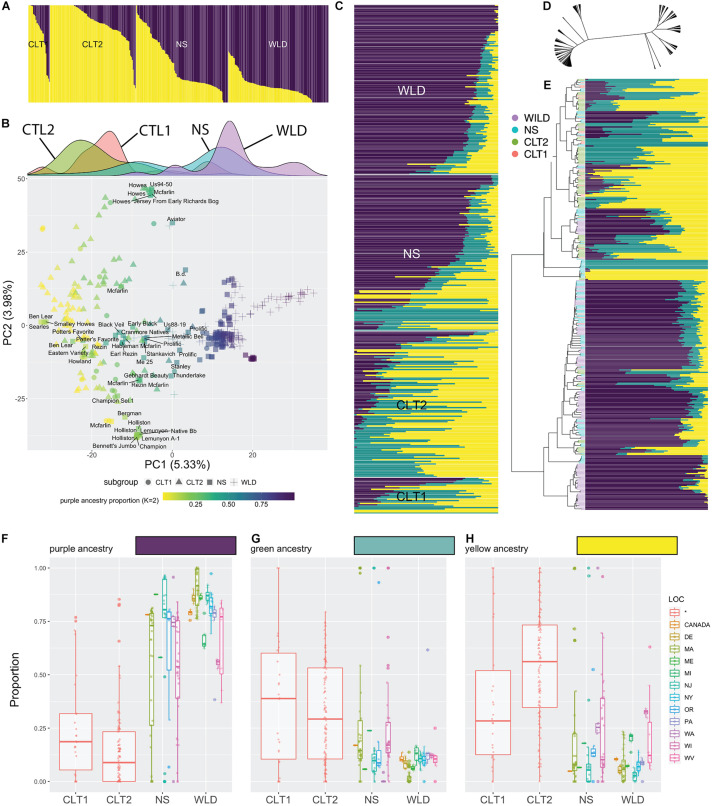
Admixture in cranberry (Vaccinium macrocarpon Ait.) subgroups resolved using 18,149 single nucleotide polymorphisms (SNP) scored on 362 accessions. (A) Results of population structure analysis, with K = 2; subgroups CLT1 (cultivars), CLT2 (advanced selections), NS (native selections), and WLD (native populations) are grouped. (B) Principal Component Analysis of 362 cranberry accessions scored with 21,177 SNP markers. Cranberry accessions are colored based on the purple ancestry proportion, when K = 2 (see panel A). Subgroups are represented as different marker symbols in the plot. Labels are shown only for NS accessions when PC1 <5. Density plots per subgroup among PC1 are shown in the top. (C) Results of population structure analysis, with K = 3, organized by subgroup. (D) Reticulated tree including the 362 accessions based hierarchical clustering (Ward’s minimum variance method). (E) Reorganization of population structure results (K = 3) based on hierarchical clustering. Proportion of each of the three ancestries (K = 3), purple (F), green (G), and yellow (H) across subgroups and their geographical origin.